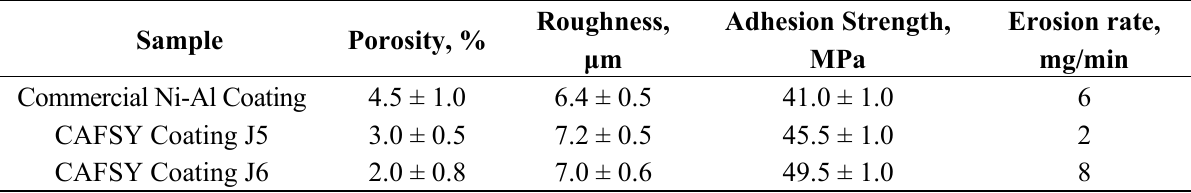
Table 5. Comparison between Sulzer Metco pre-alloyed powder coating and two different coatings produced by CAFSY